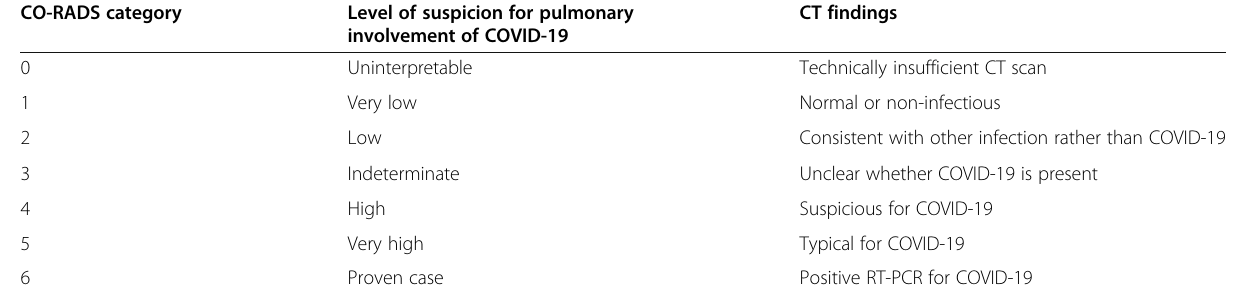
Table 1 Overview of CO-RADS categories CO-RADS category